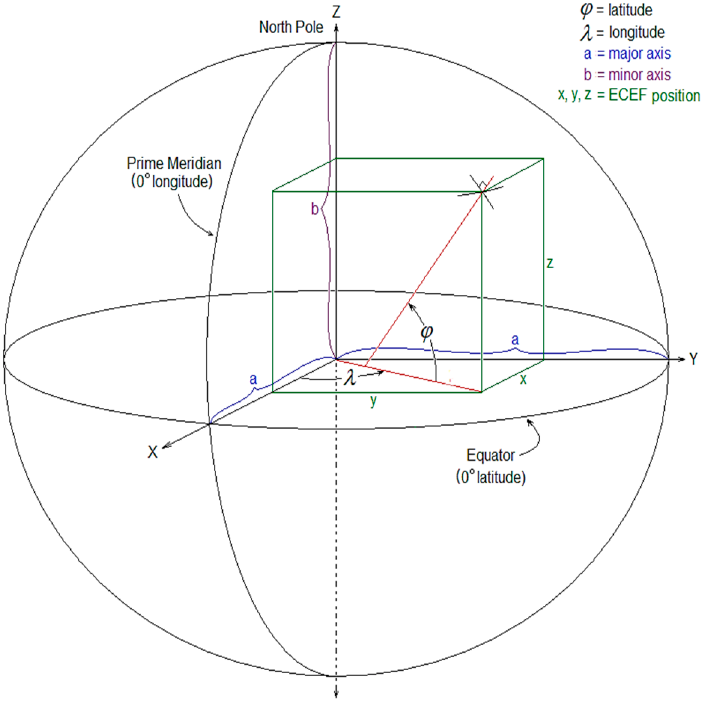
Figure 4. Adopted ECEF coordinate system [43].